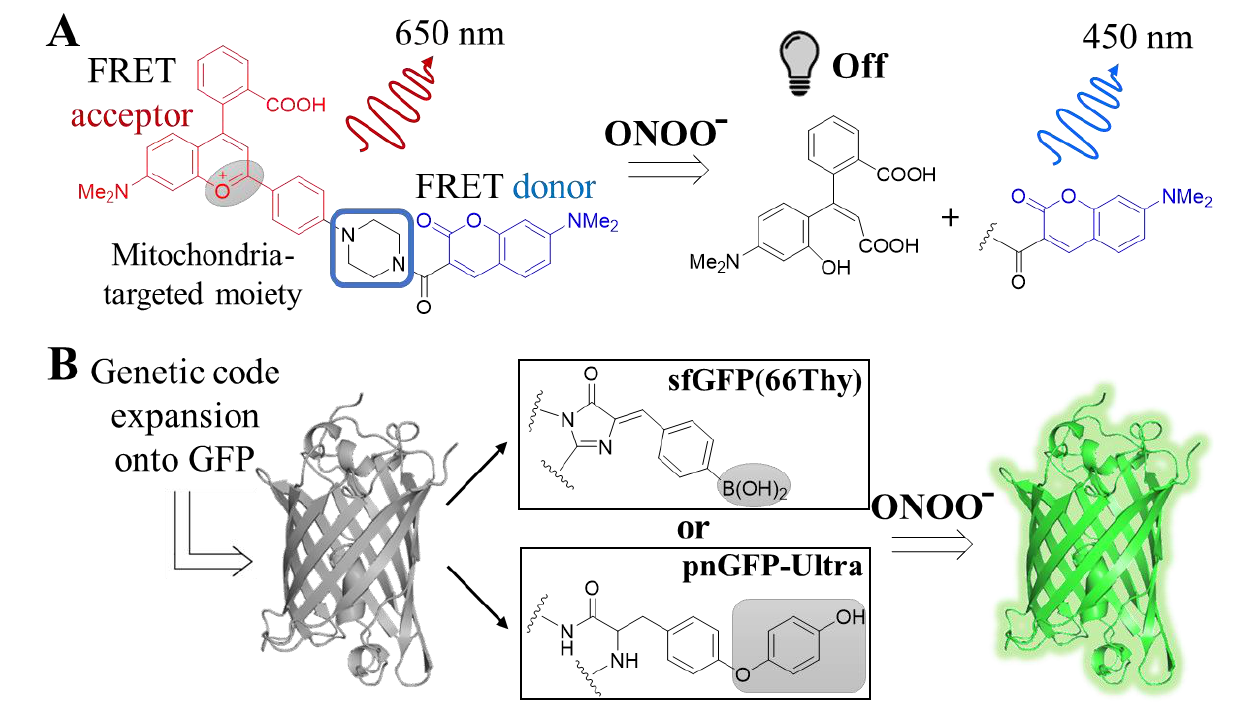
Figure 4. Peroxynitrite-selective tools and their mechanism of detection. ( A ) Structure and mechanism of the small molecule FRET probe MITO-CC. The probe consists of a FRET donor and an acceptor as well as a linker, which is also the group responsible for sending the probe into mitochondria. In the absence of ONOO − , the probe emits at 650 nm due to energy transfer from the donor to the acceptor. However, upon reaction with ONOO − , the FRET acceptor is eliminated and decomposed, and the remaining donor fluoresces at 450 nm. ( B ) GFP variants sfGFP(66Thy) and pnGFP-Ultra with non-natural amino acids. Genetic code expansions on GFP using non-natural amino acids (shown in the boxes) led to the generation of GFPs that are non-fluorescent. The non-natural amino acids are equipped with ONOO — sensitive groups, which upon reaction are cleaved off and the resulting GFP is then fluorescent.